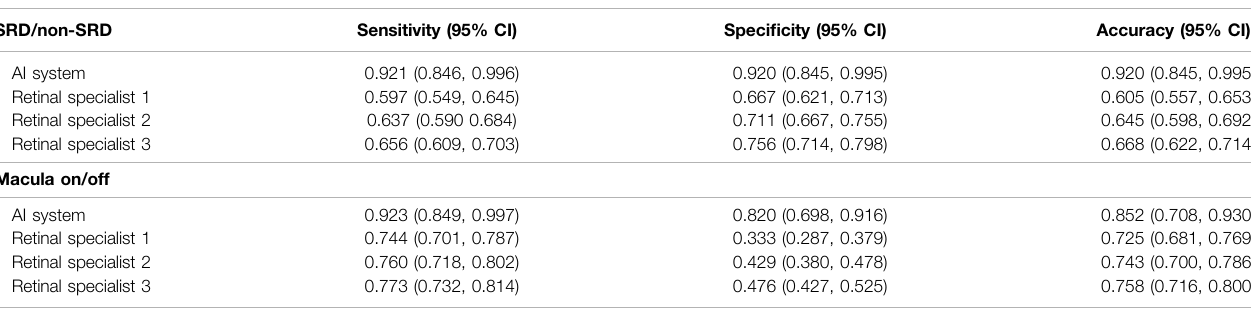
TABLE 2 | Performance of the AI systems vs. general ophthalmologists in the test